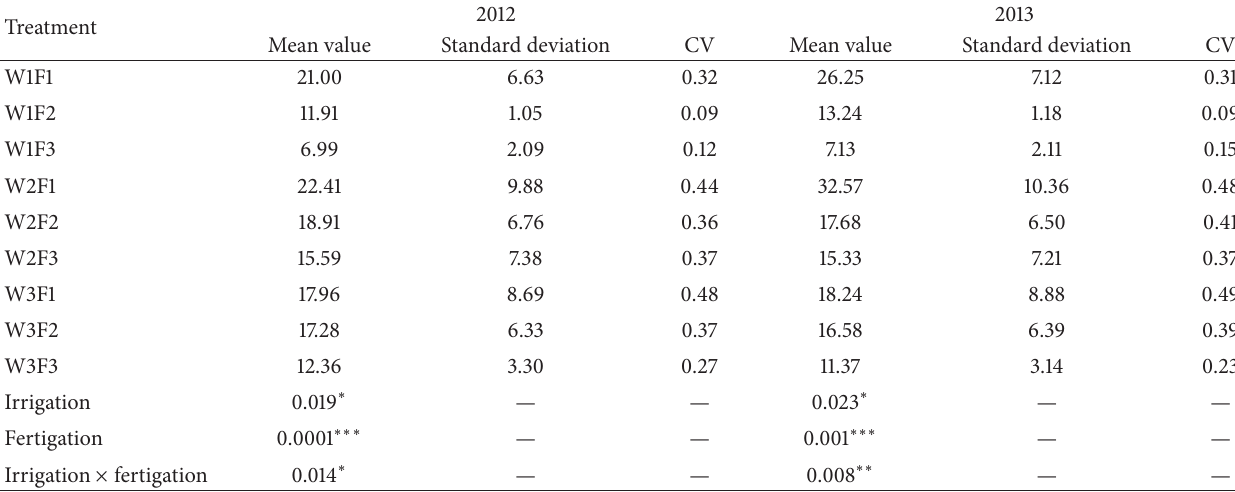
Table 2: Statistical analysis of soil NO 3− -N content from 0 to 60cm soil depth was analyzed on different irrigation and fertilization treatment.